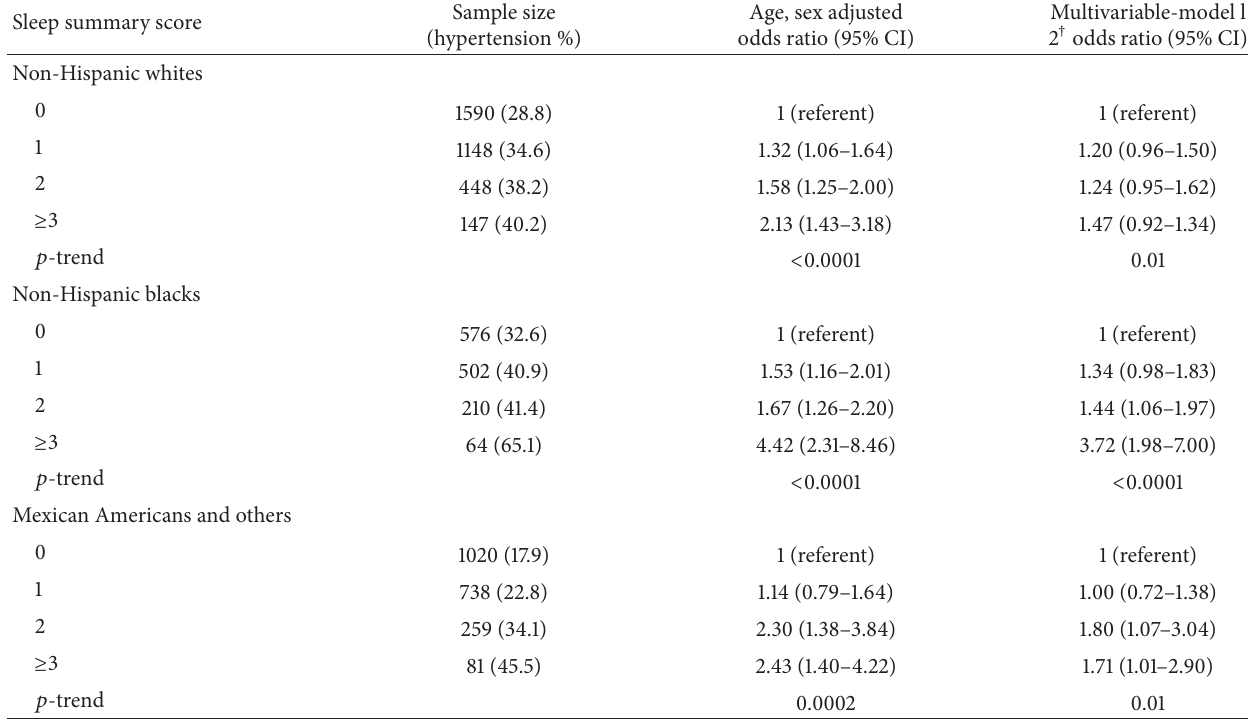
Table 4: Association between sleep variables and hypertension, by